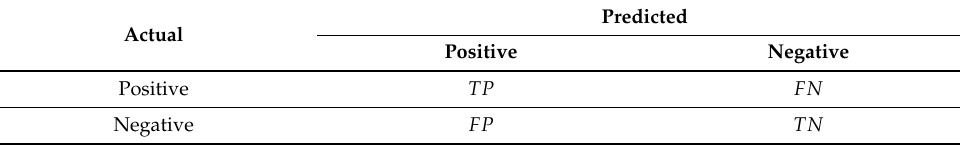
Table 3. The definition of some fundamental